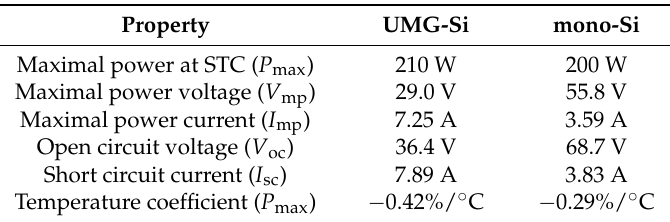
Table 1. Electrical properties of photovoltaic (PV)